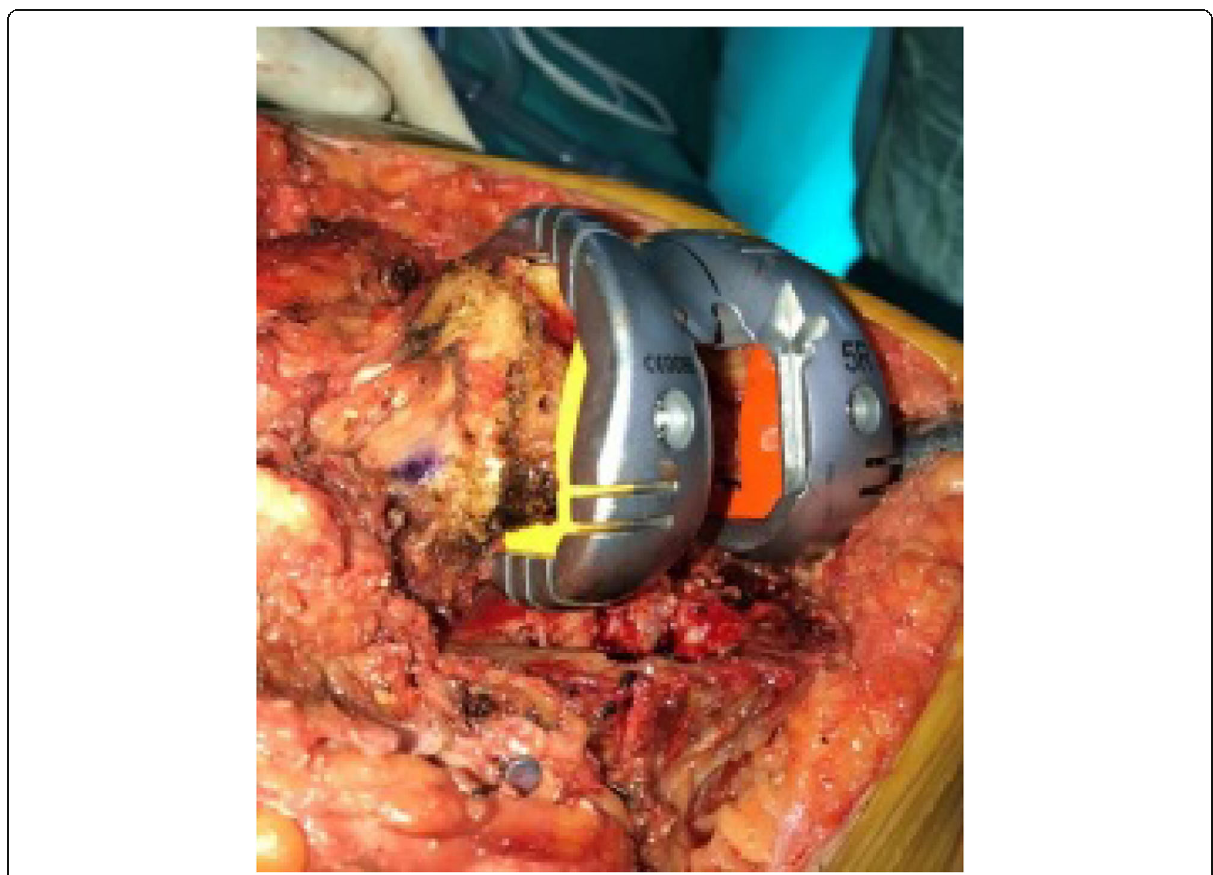
Fig. 4 JL and PJL restoration with trial prothesis using